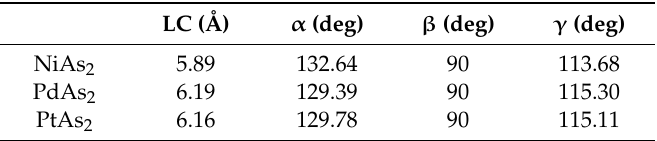
Figure 1. ( a ) Top and ( b ) side views of the monolayer MAs 2 (M = Ni, Pd, Pt). The pentagonal unit is marked by a black ellipse. Table 1. Lattice constants (LC) of 2D MAs 2 (M = Ni, Pd, Pt) sheets and the degrees of α , β and γ angles.